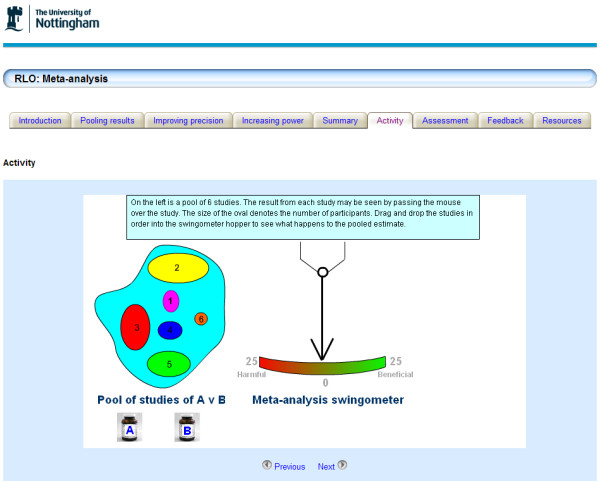
Screen shot from the Introduction to Meta-analysis RLO. The RLO is divided into sections each having a tabbed heading. RLOs contain animations, activities and self assessments.